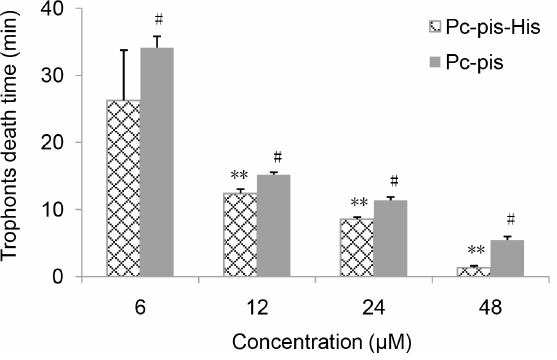
Figure 3. Antiparasitic activity of Pc-pis-His and Pc-pis against C.irritans trophonts. The data are shown as the means 6 SD (N $ 3). Significant differences and extremely significant difference between the Pc-pis-His group and the Pc-pis group at each concentration are indicated with * ( P , 0.05) and ** ( P , 0.01), respectively. # Data comes from [1].